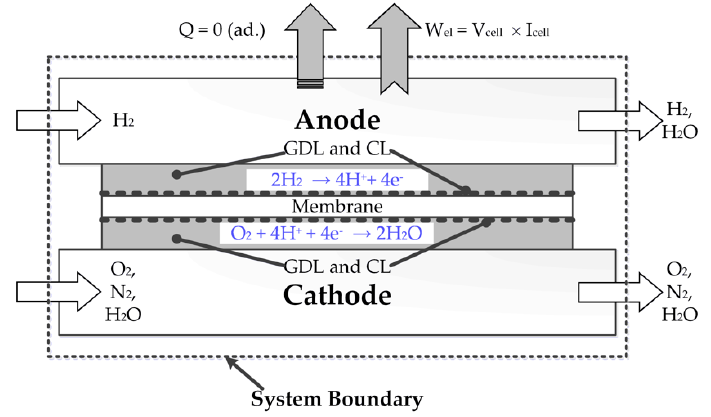
Figure 3. System boundary for the first-law analysis.